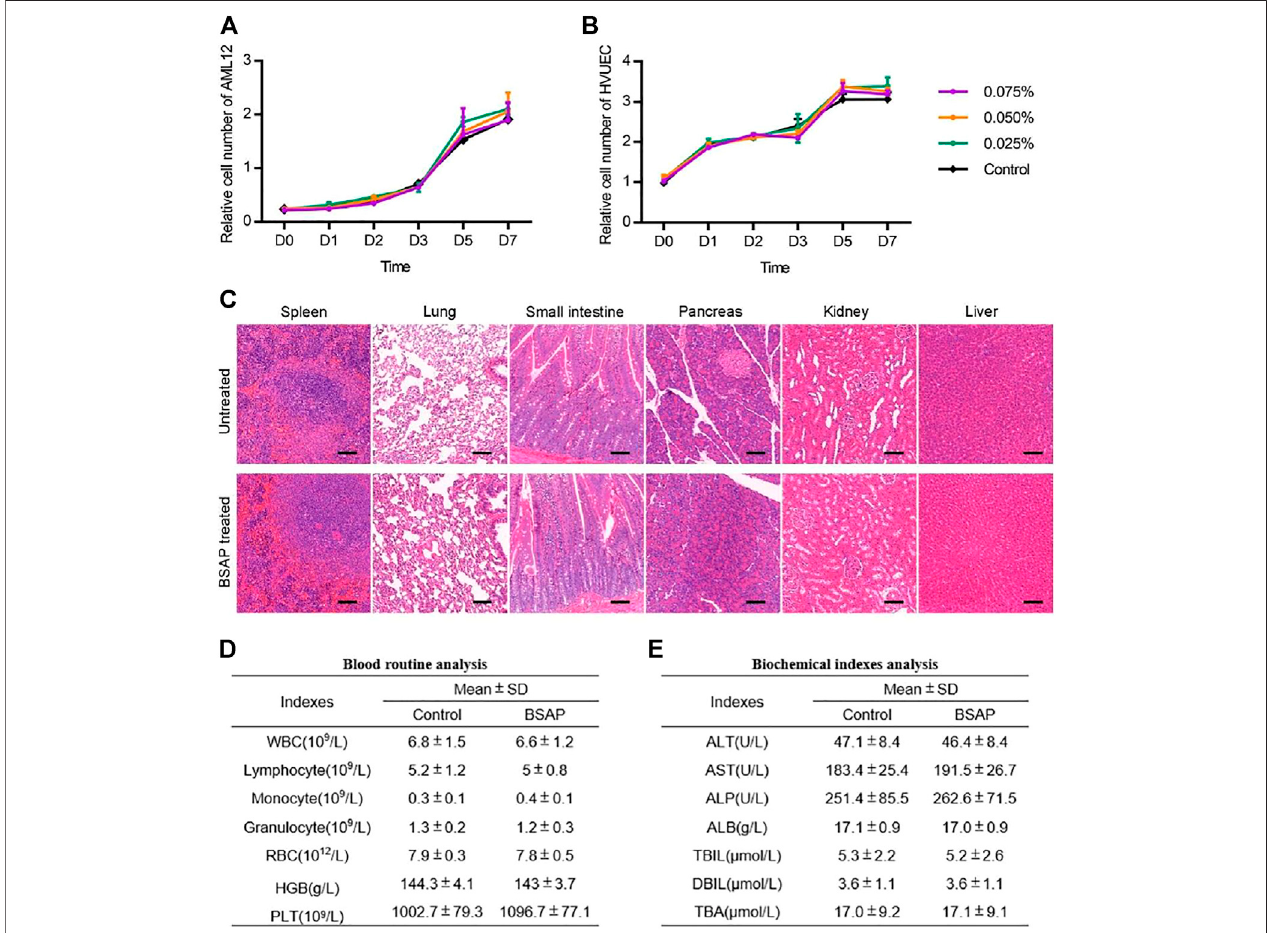
FIGURE 5 | Toxicity evaluation of BSAP hydrogel. (A) and (B) Time-dependent cytotoxic activity of 0.075, 0.050, 0.025, 0% (control) BSAP in culture medium against (A) AML12,mouselivercellsand (B) HUVEC,humanumbilicalvein( n =3). (C) RepresentativehistologicalHandEstainingimagesofspleen,lung,smallintestine, pancreas, kidney and liver tissue sections with and without the BSAP hydrogel treatment in full-thickness skin wounds model on day 14 after BSAP hydrogel treatment. Scale bar represent 100 μ m. (D) Blood routine analysis in full-thickness skin wounds model (without infection) on day 3 after BSAP hydrogel treatment ( n = 3). (E) Biochemical index analysis in full-thickness skin wounds model (without infection) on day 3 after BSAP hydrogel treatment ( n = 3).